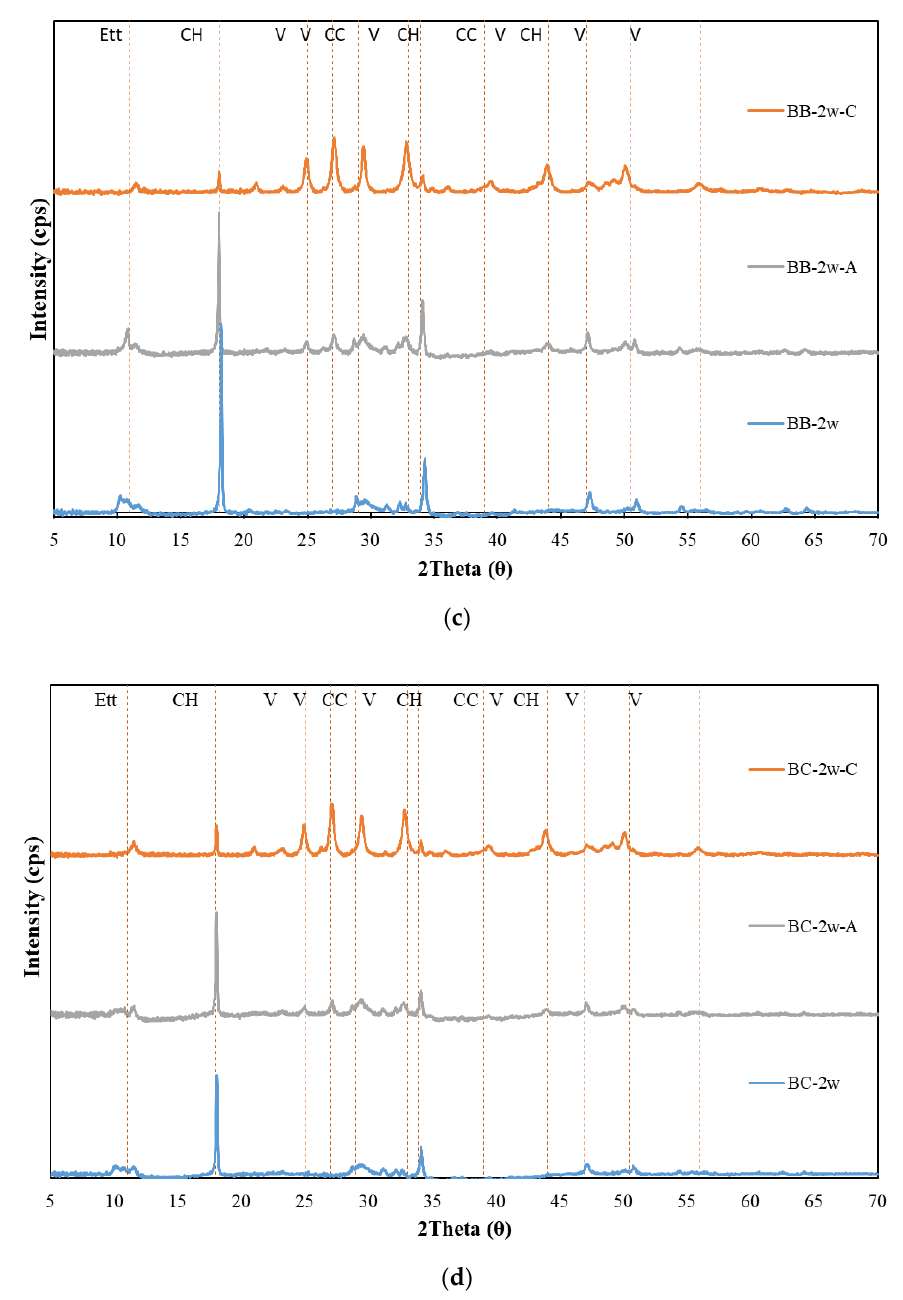
Figure 2. XRD patterns of carbonated cement paste. ( a ) N; ( b ) BA; ( c ) BB and ( d ) BC.